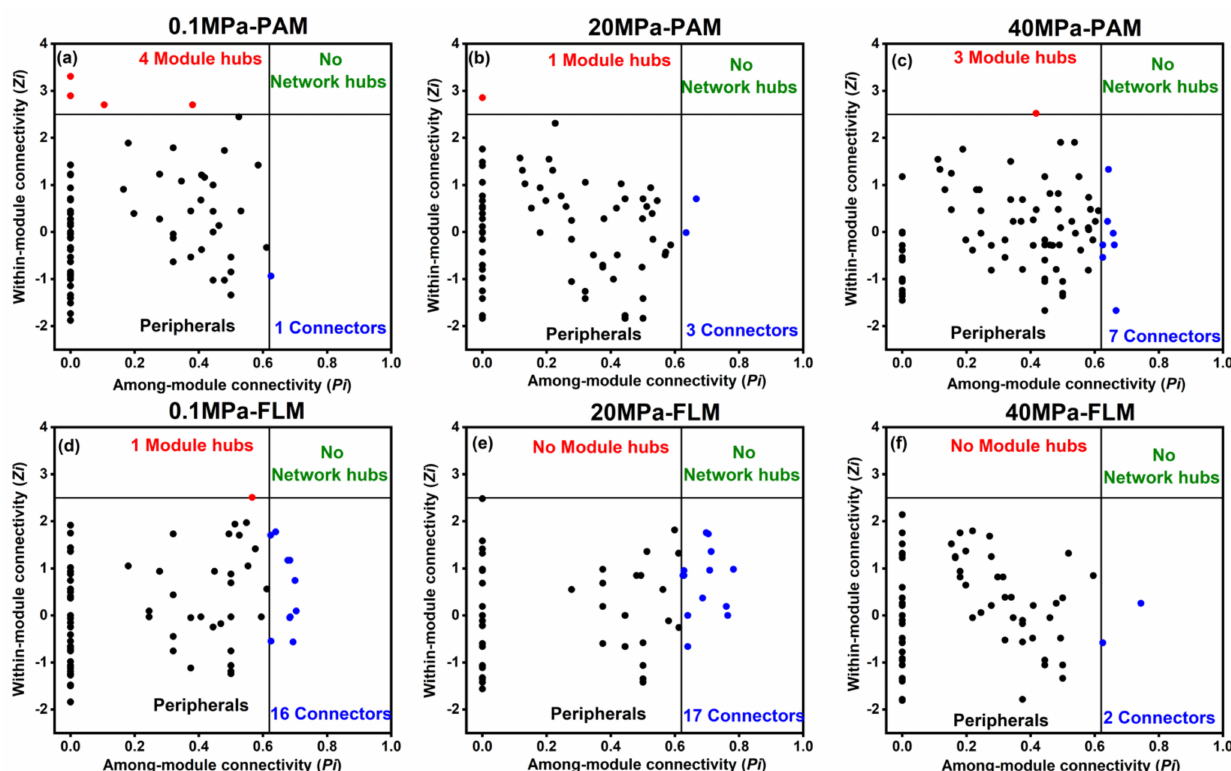
Figure 6. ZP − plot showing putative keystone species within the PAM and FLM networks during POM sinking at 0.1, 20, and 40 MPa, respectively. Each dot represents an OTU from the six networks selected for detailed module analysis (Figure 5). The module hubs (Zi > 2.5) and connectors (Pi > 0.62) are shown as red and blue dots, respectively. Detailed taxonomic information for module hubs and connectors is listed in Table S6. ( a ) 0.1 MPa − PAM; ( b ) 20 MPa − PAM; ( c ) 40 MPa −